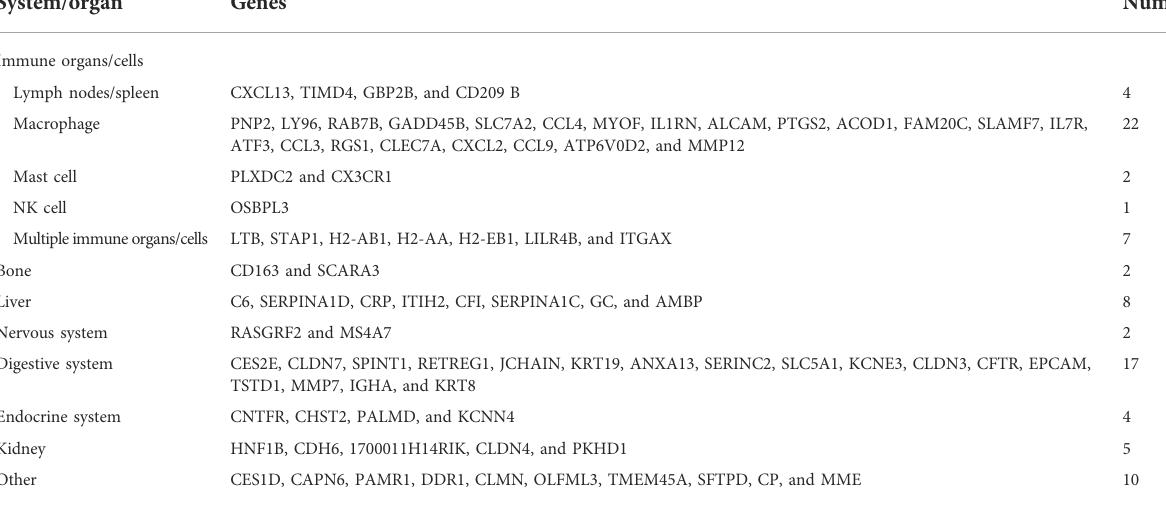
TABLE 2 Distribution of tissue- and organ-speci fi c expressed genes identi fi ed by BioGPS. System/organ Genes Immune